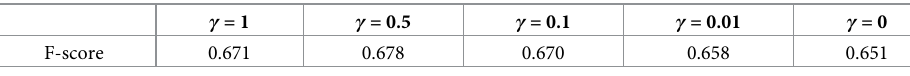
Table 5. F-score with the variation of hyperparameter γ .